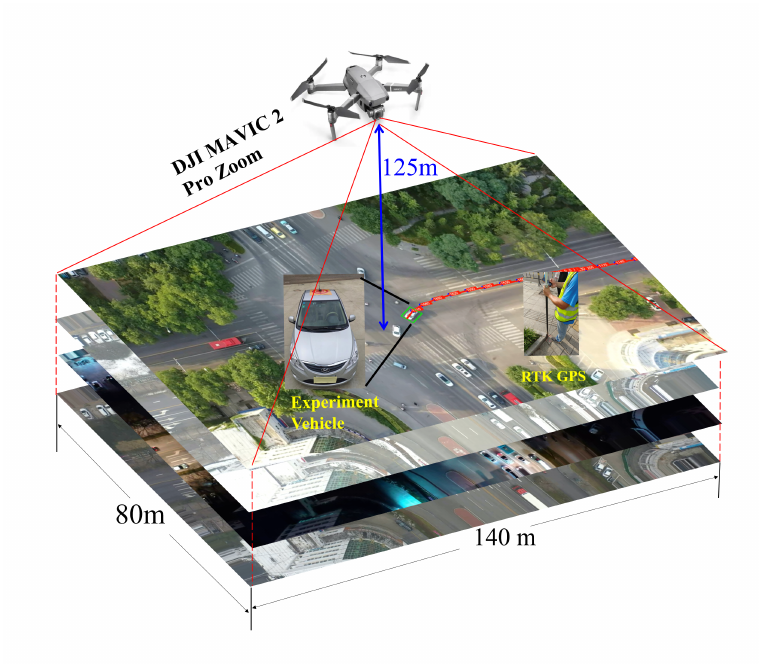
Figure 9. Process of collecting UAV video at urban intersections under different weather conditions.